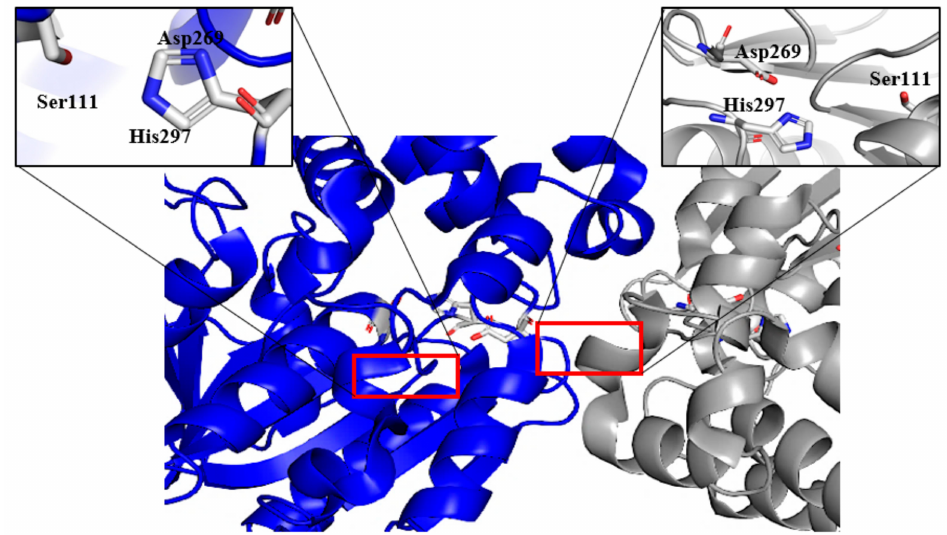
Figure 7. The overall structure of Ga PIP at 2.4 Å. Chain A (grey) and Chain B (blue) are